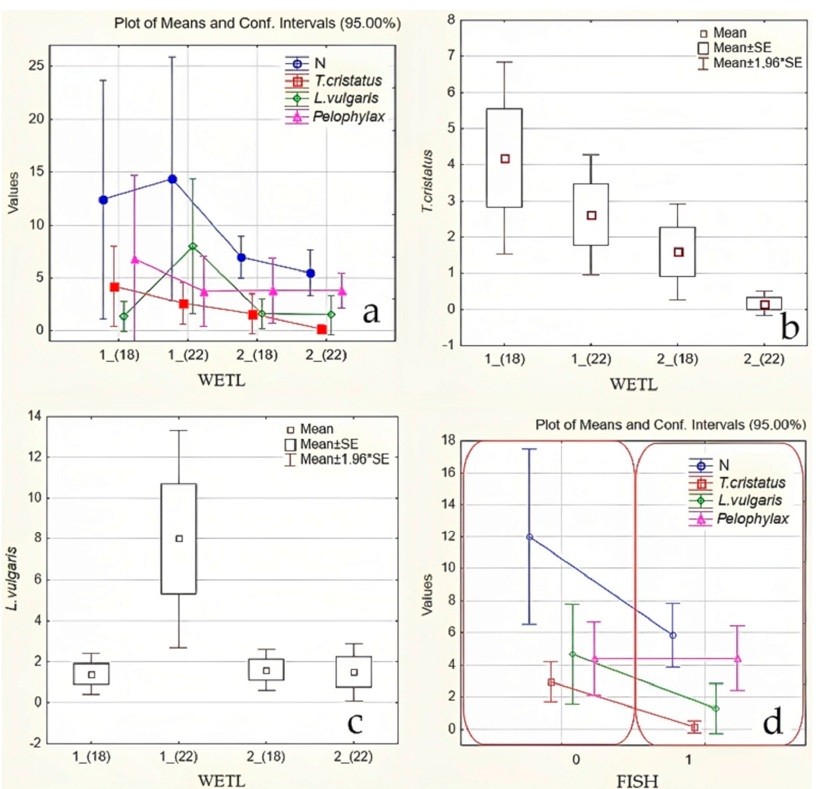
individuals of L. vulgaris , depending on the isolation of the pond (“wetl”): (1) geographically iso-